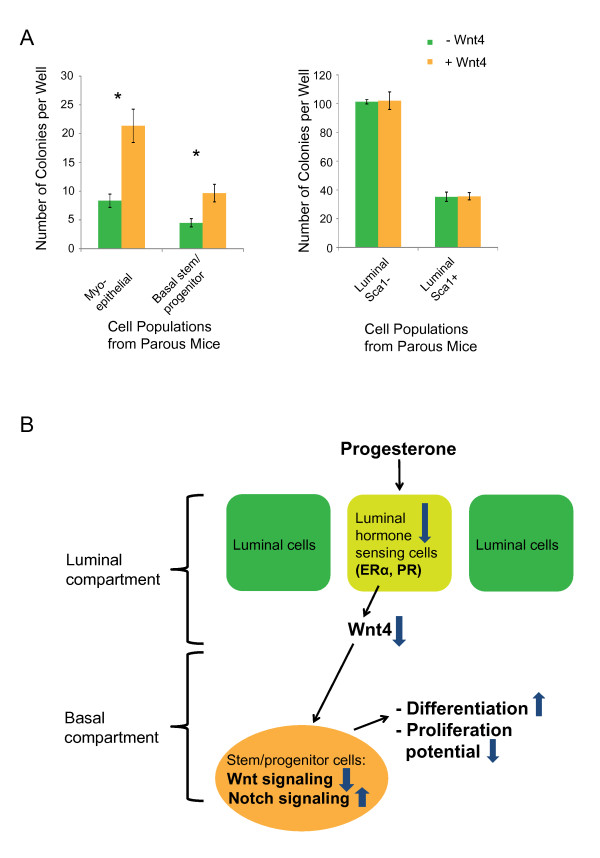
Effect of Wnt4 on the proliferation capacity of basal stem/progenitor cells after early pregnancy in mice. (A) Recombinant Wnt4 rescues the parity-induced in vitro proliferation defect in basal mammary epithelial cells. Selected mammary epithelial cells from parous mice were cultured in the absence or presence of recombinant Wnt4. Three independent experiments were performed. Data represent the mean ± SEM of colonies per well, with six to nine wells assessed per cell type. *P ≤ 0.02 (two-tailed unpaired Student t test). (B) Mechanistic model illustrating the parity-induced decrease in hormone-sensing and Wnt4-secreting luminal cells on the Wnt/Notch signaling pathways and the proliferation/differentiation potential in basal stem/progenitor cells.